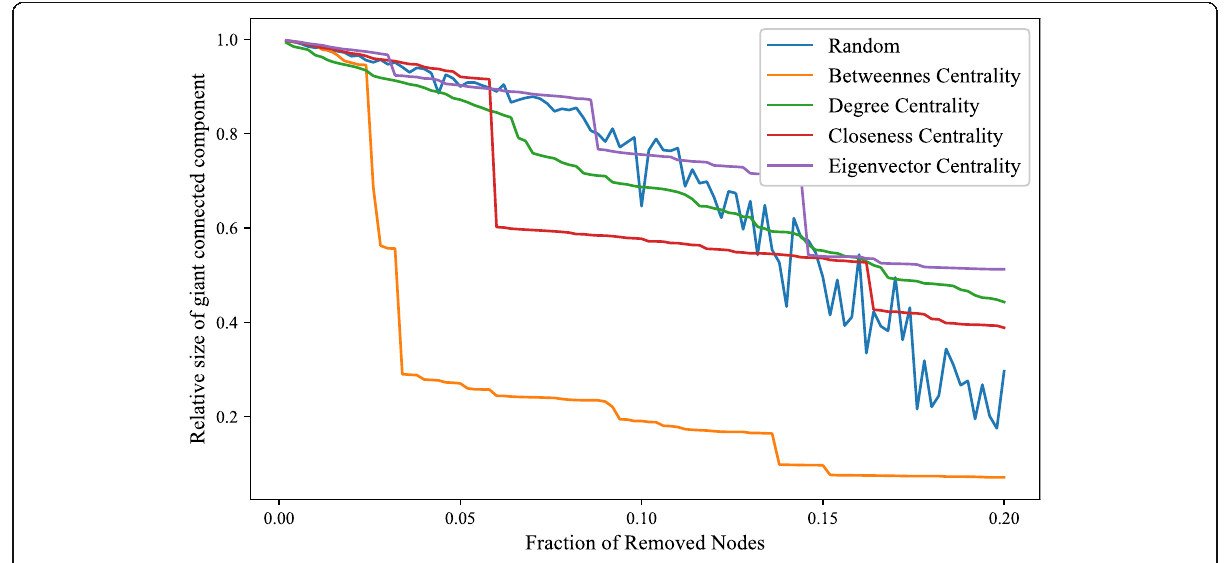
Fig. 8 Connectivity Profile of Road Network under Different Targeted Disruption